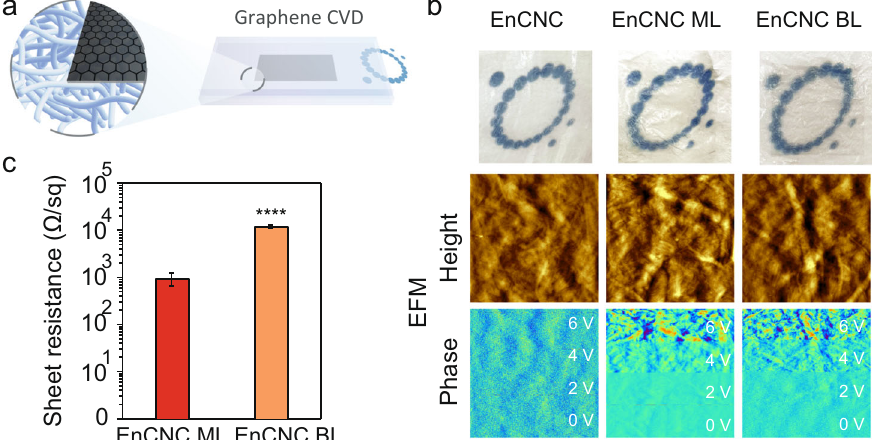
Fig. 6 CVD graphene over nanocellulose fi lm. a Illustration of CVD graphene monolayer transferred over nanocellulose transparent fi lm. b Photographs and EFM images of EnCNC fi lm, CVD graphene monolayer (EnCNC ML), and CVD graphene bilayer (EnCNC BL) over EnCNC. EFM height and phase images from EnCNC, EnCNC ML, and EnCNC BL. Topography of the fi lms was shown in the height images and the phase showed the response of the fi lms to different voltage bias 0, 2, 4, and 6 V, from the AFM tip to the sample. c Sheet resistance measurement of EnCNC ML and EnCNC BL. The average values and SD were calculated from two independent experiments (* P < 0.05; ** P < 0.01; *** P < 0.001; **** P <